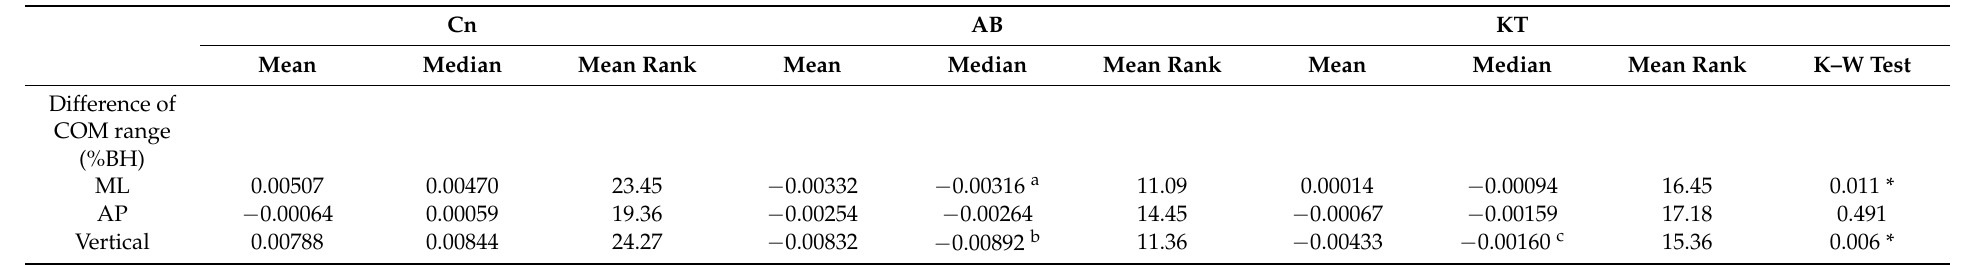
Table 3. Kruskal–Wallis and post hoc test results for fatigue-induced changes in the COM range in lateral drop landing tasks performed by the three groups. Cn KT Mean Median Mean Rank K–W